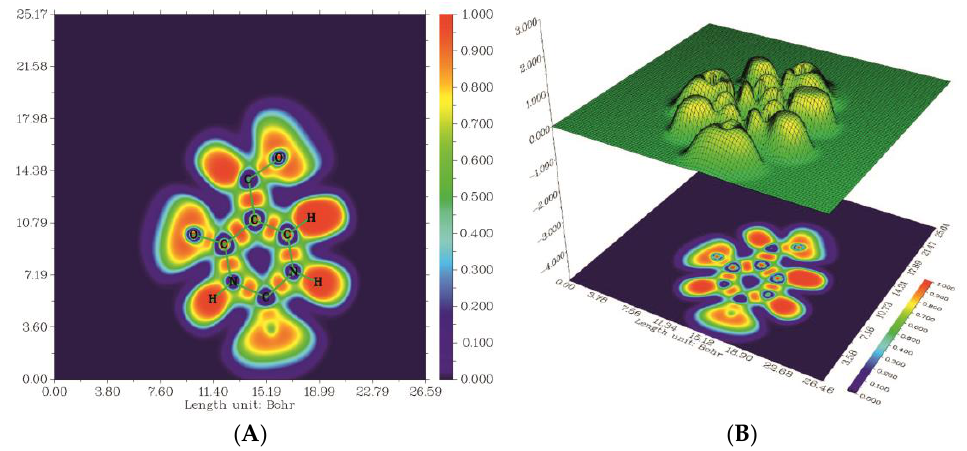
Figure 6 . ELF ( A ) Color filled map, ( B ) Shaded surface map with projection of 5-HMU.